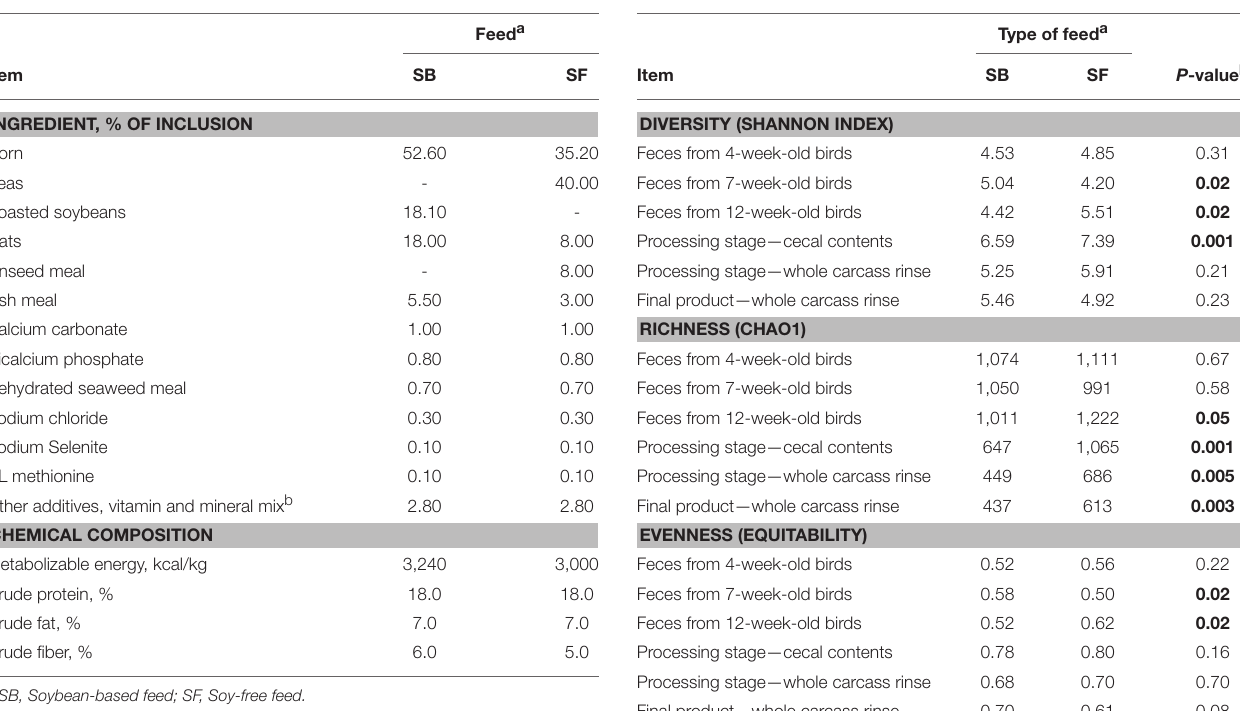
TABLE 2 | Effect of diet on α diversity indices at 97% similarity after rarefaction to 4,400 sequences per